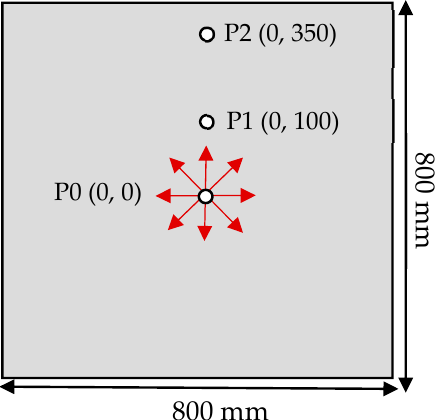
Figure 3. PZT transducer configuration to measure the S 0 mode group velocity 𝑣 .